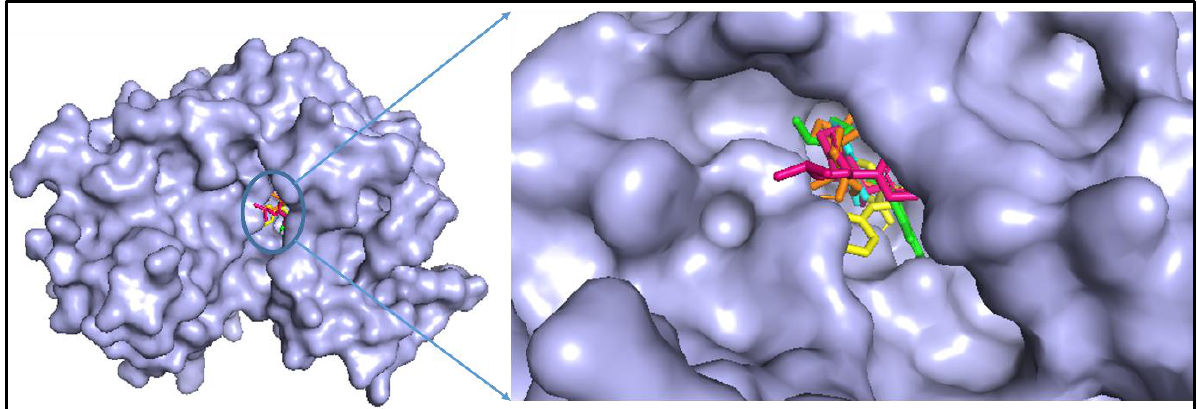
Figure 5. Surface diagram with docked ligands in the active site. The surface representation (PDB: 4EKL) shows the binding mode of the original crystallized ligand GDC0068 (pink) and the docked ligands isoliquiritigenin (yellow), theophylline (cyan), tehranolide (orange), and shogaol (green). Figure made using PyMOL v2.5.0.